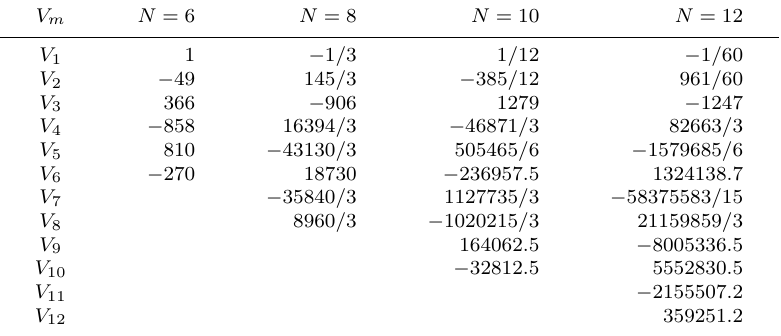
Table 1. Values of V m of the Stehfest